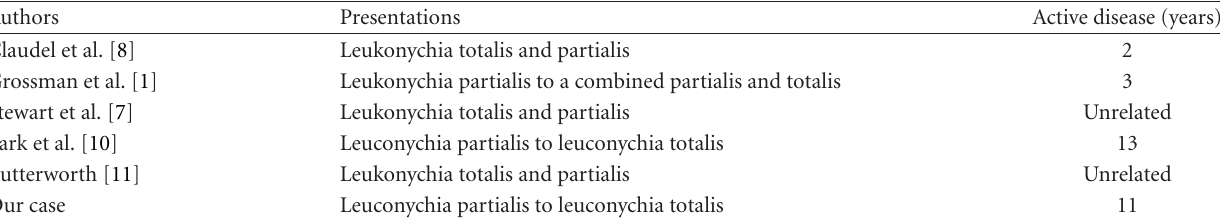
Table 2: True acquired idiopathic